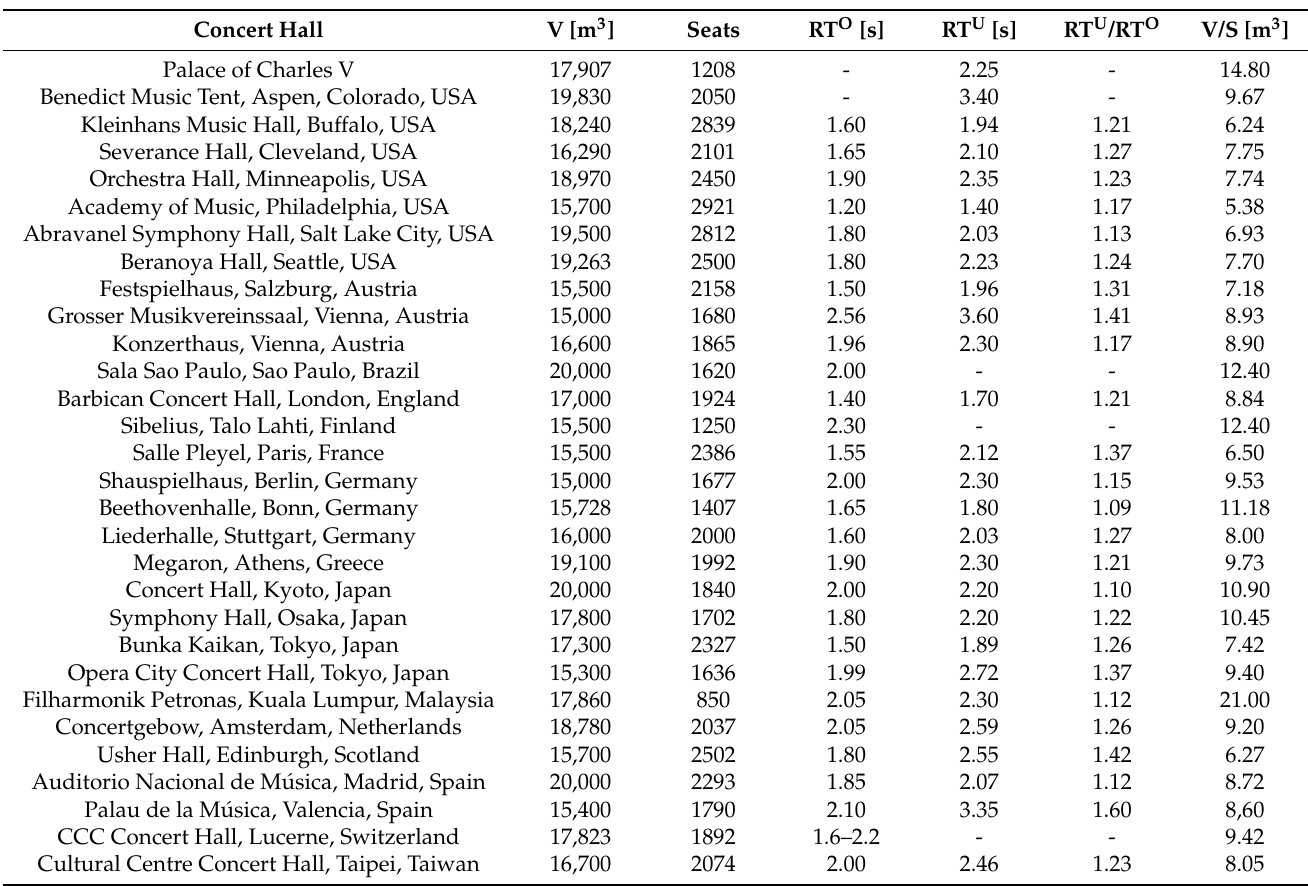
volume per occupant much lower than the Palace’s. Table 8. Technical details of the 29 halls between 15,000 and 20,000 m 3 from Beranek [55]. Concert Hall V [m 3